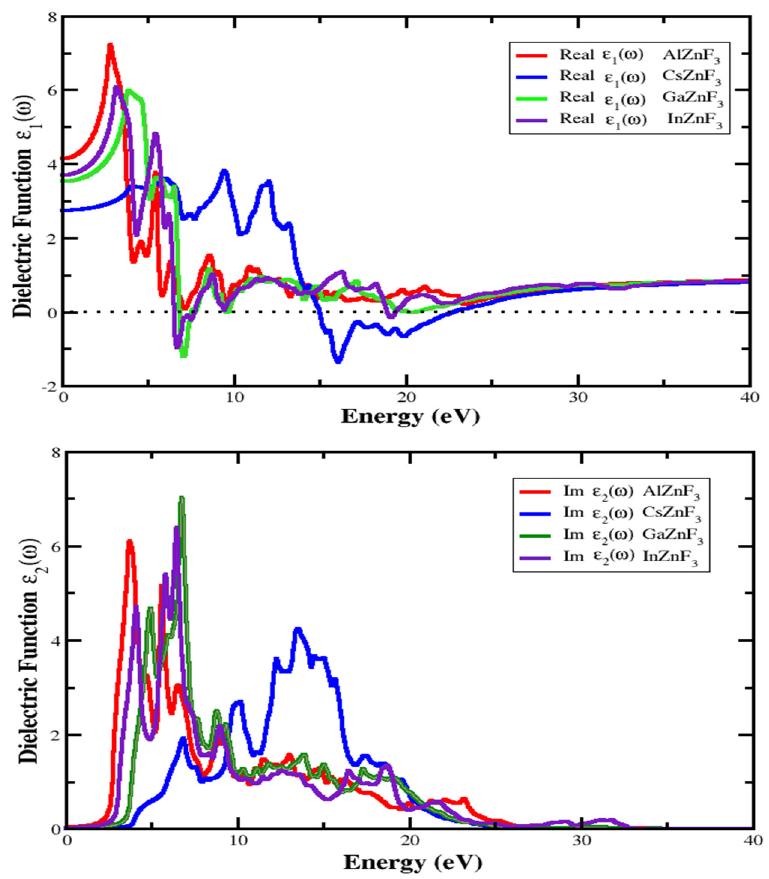
Figure 5. Real part ε 1 ( ω ) and imaginary part ε 2 ( ω ) of the dielectric function for XZnF 3 compounds (X = Al, Cs, Ga, In).